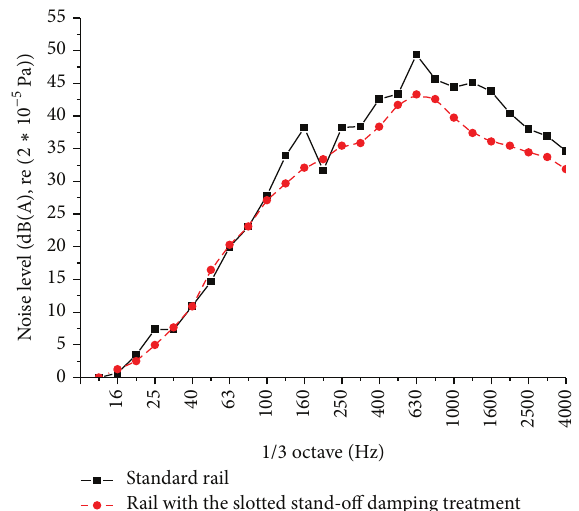
Figure 18: One-third octave curve in vertical excitation.